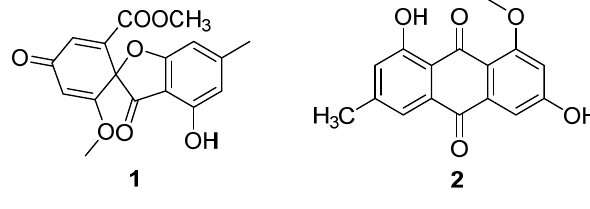
Figure 1. Structure of polyketides 1 and 2 [20]. Table 1. Compounds with cytotoxic activity.